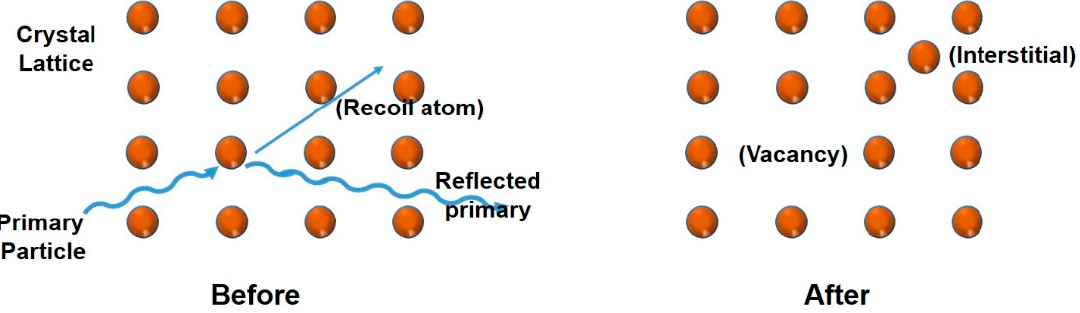
Figure 4. Schematic of atomic displacement damage in crystalline solid before and after exposure to radiation particles.